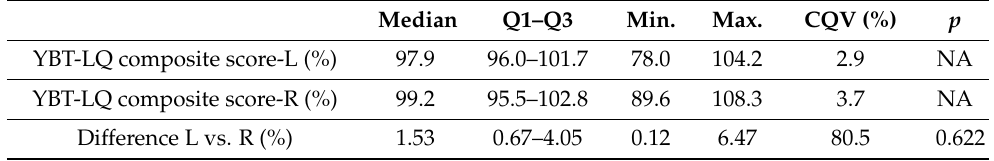
Table 4. Summary of Lower Quarter Y-balance test composite